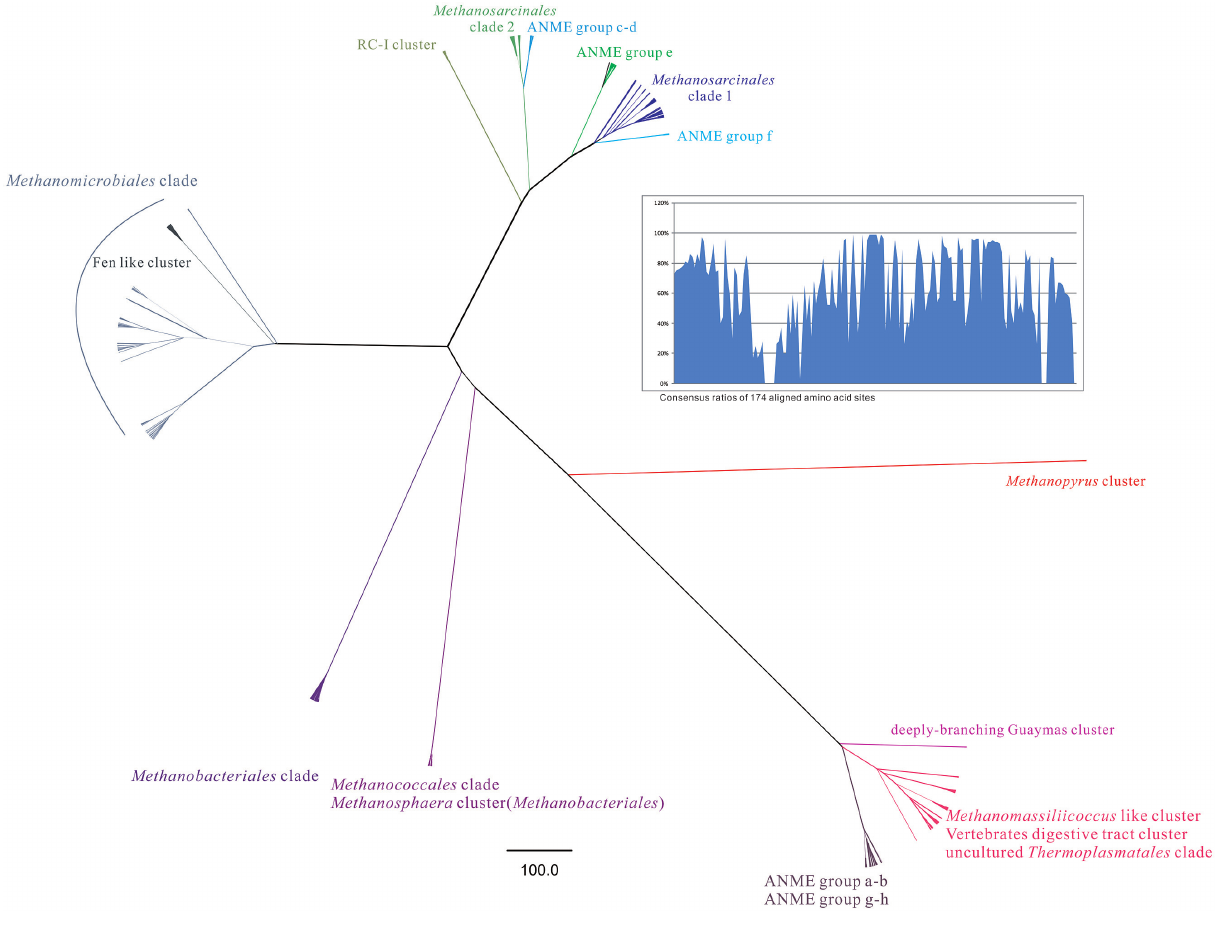
FIGURE 4 |The radical phylogenetic tree was constructed by the MrBayes 3.2.1 vision based on CIPRES Science GatewayV. 3.3 server (http://www.phylo.org/). In total 800 mcrA gene sequences from this study and referred GenBank database was used to build the alignment with 174 amino acid sites including empty sites.The Markov chain Monte Carlo running generation setting was given as 1000000 and 100% majority rule was utilized to conduct a consensus tree.The tree was finally rooted by the out-group of